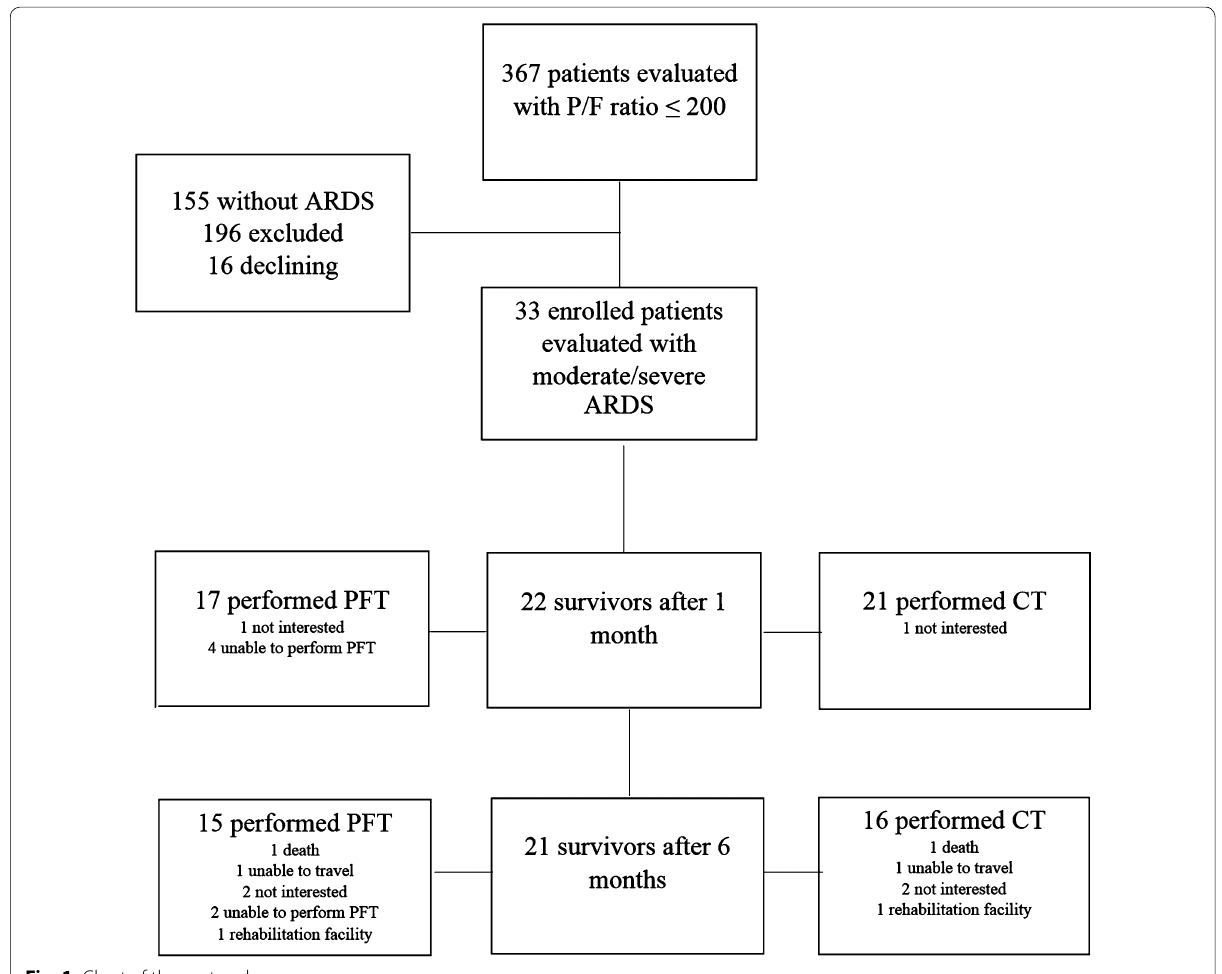
CT scan analysis aerated lung volumes were all significant, as well as the